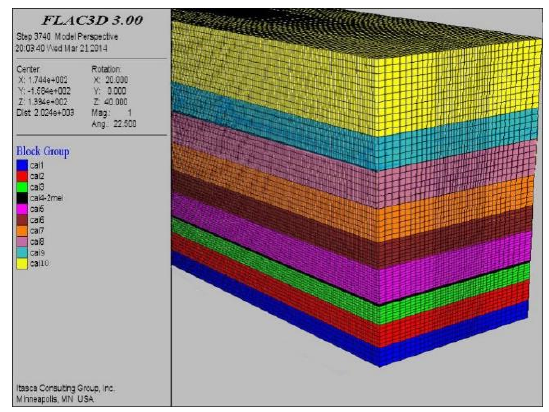
Figure 6. Numerical model. Table 1. Physical and mechanical parameters of rock mass of each formation in the simulation area.